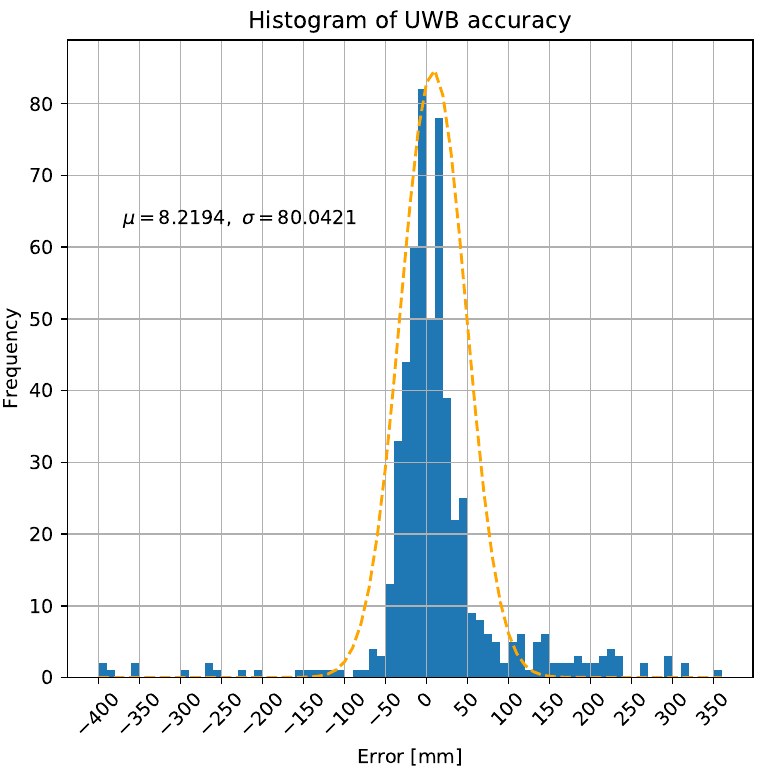
Figure 8. Statistical characteristics of UWB